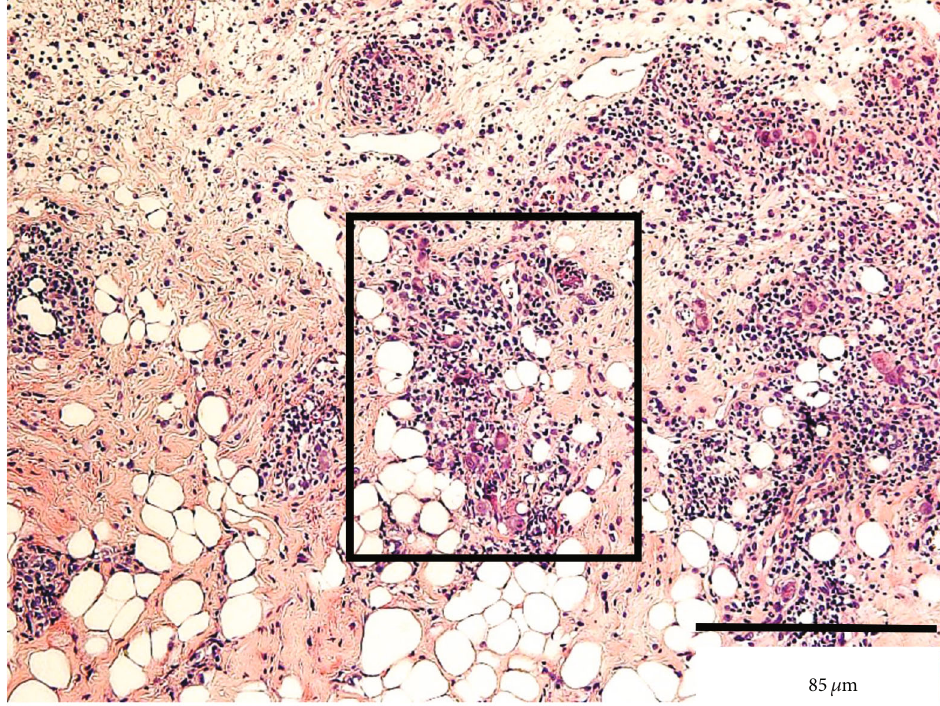
Figure 2: Histopathological fi ndings of the specimen obtained from the biopsy of the ulcer. The black box shows vascular endothelial cells containing enlarged nuclei with intranuclear inclusions (hematoxylin-eosin staining). Bar: 85 μ